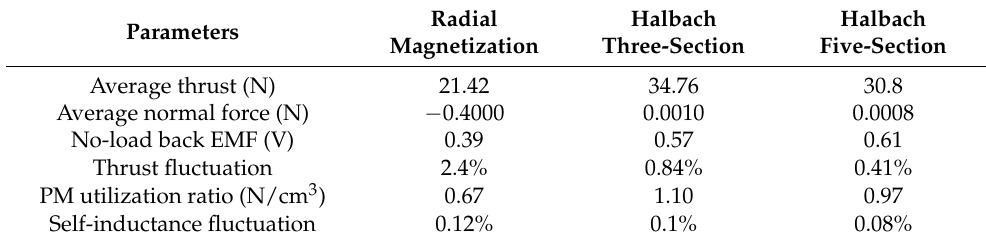
Table 3. Comparison of different electromagnetic actuators.